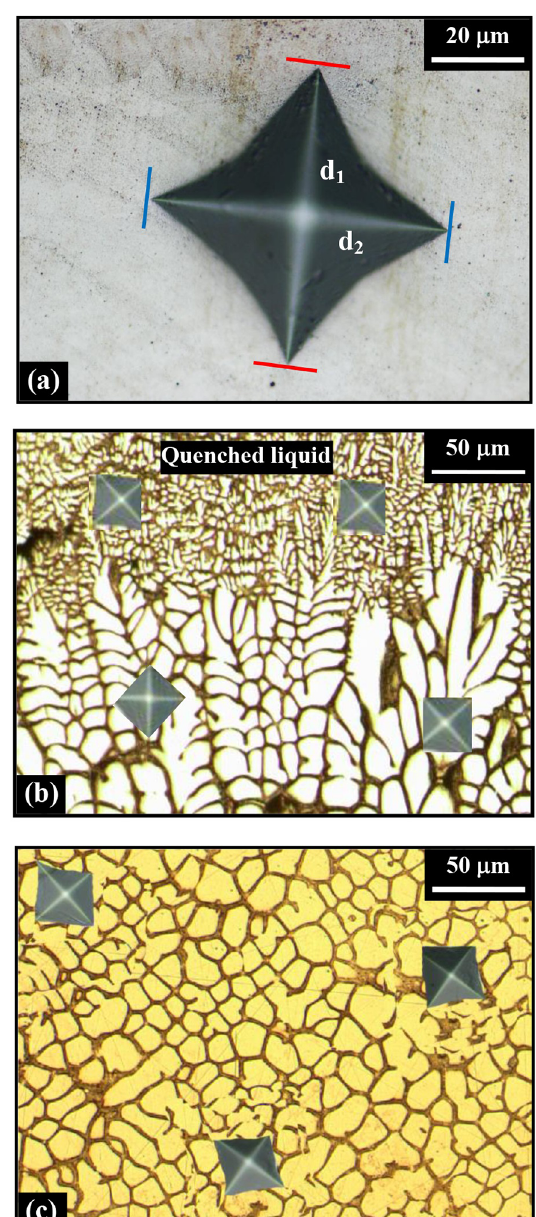
and d ), (b) the indenter traces 1 2